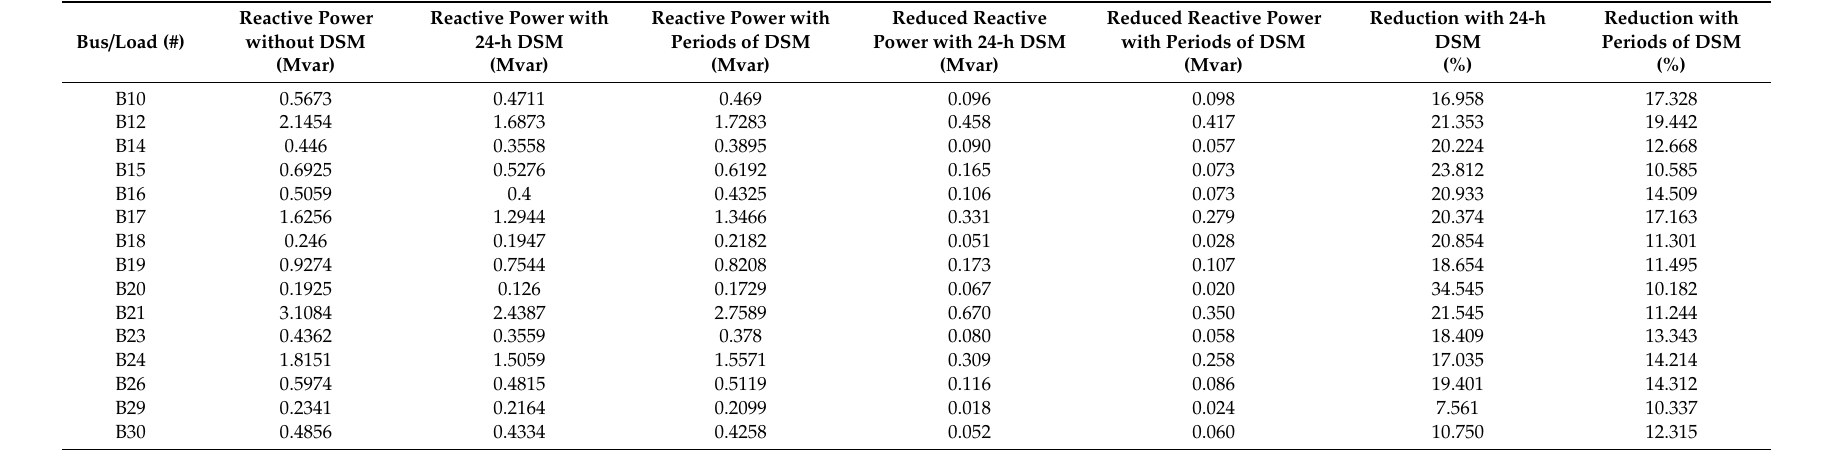
Table 11. Case VIII: Reactive power with / without DSM in the presence of